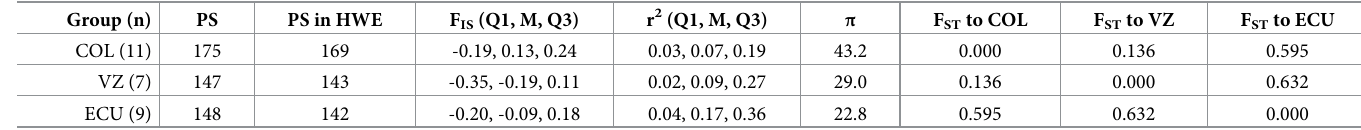
Table 3. Basic diversity statistics for T . cruzi I samples from Colombia (COL), Venezuela (VZ) and Ecuador